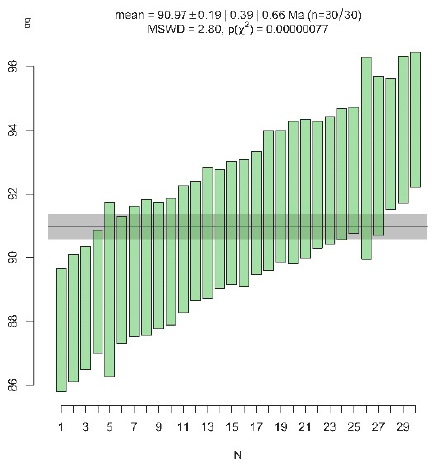
Figure 6. The new obtained weighted mean 206 Pb / 238 U data. The raw data are available in Supplementary Material 2. ( a – c ) drill hole RTN 1405; ( d ) drill hole RTN 1402; ( e ) drill hole RTN 1404; ( f ) drill hole RTN 1408; ( g ) drill hole RTN1406.